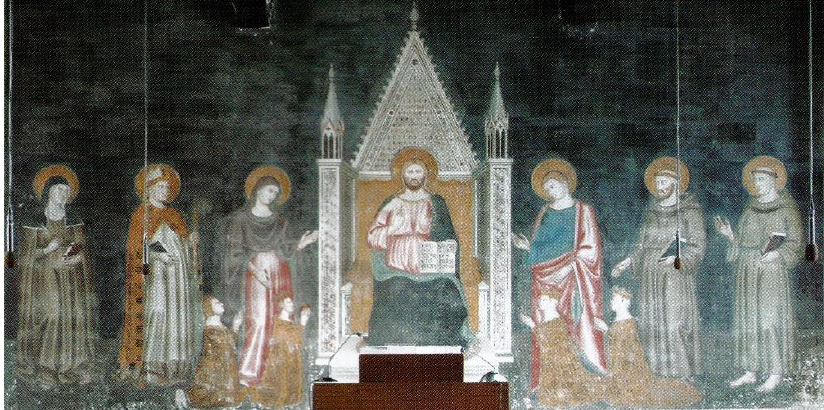
Figure 5. The so-called Lello da Orvieto, Christ enthroned between saints and Angevin royals , fresco, 1336–1337. Naples, Monastery of Santa Chiara, former male chapter house. Image published in: [12] (Figure